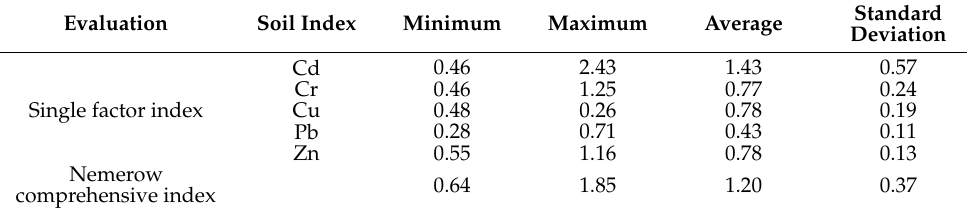
Table 6. The descriptive statistics of heavy metal evaluation